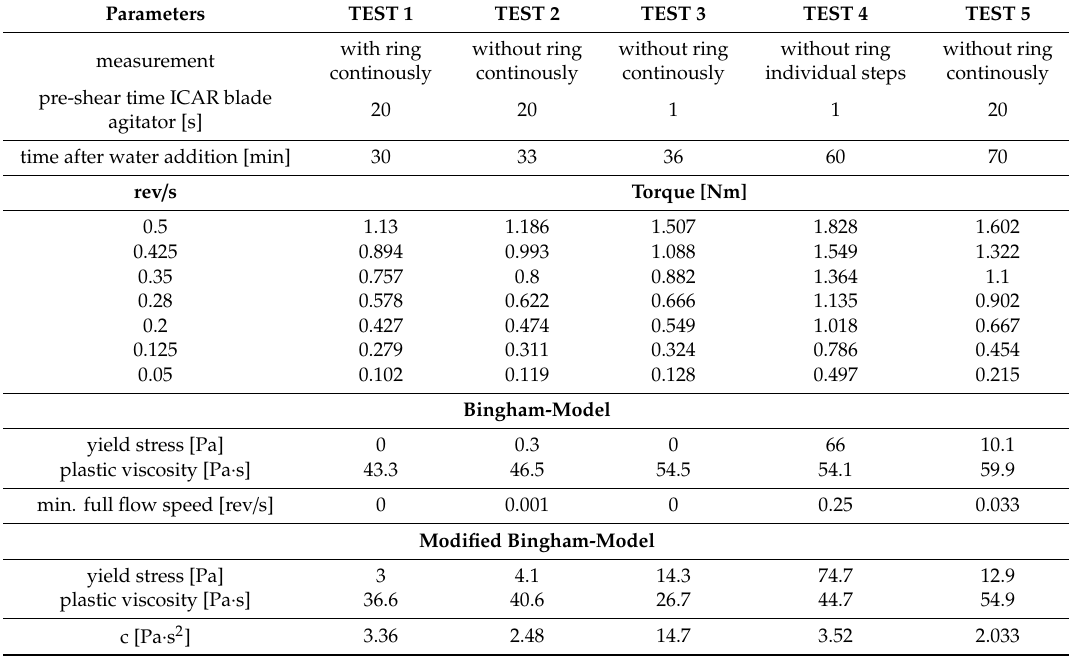
Table 3. Results for the comparative measurements of the ICAR rheometer under di ff erent boundary conditions. Carried out with a SCC according to Table 1.